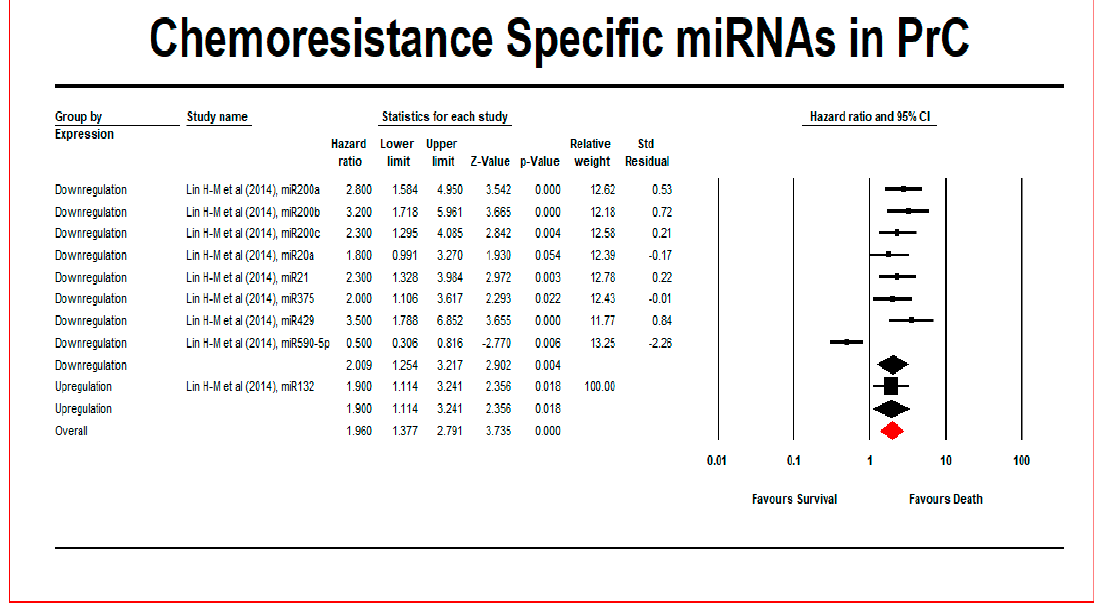
Figure 4. Title: meta-analysis of chemoresistance-specific miRNA in PrC patients. Figure 4 legend: The black diamond from Figure 4 graphically represents the pooled effect estimate of survival for PrC patients randomly assigned to evaluate the chemoresistance specific miRNA. The vertical line and red box indicate the effect size of miRNA expression in the included studies with a 95% CI. A HR of 1 suggests no difference in risk in PrC patients.